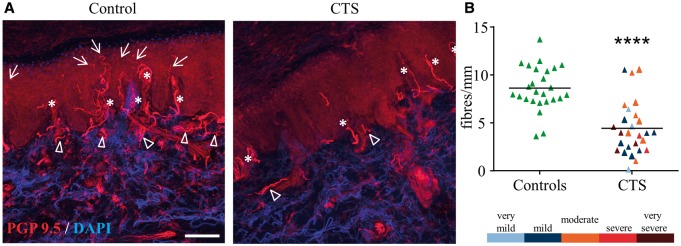
Patients with carpal tunnel syndrome have a reduced intraepidermal nerve fibre density. Images in (A) show representative skin biopsy sections from an age matched control participant (left) and a patient with carpal tunnel syndrome (CTS, right). Whereas there is an abundance of axons (red, protein gene product, PGP9.5) in the subepidermal plexus (arrow heads), the papillae (asterisks) and the epidermis (arrows) in the control skin, the skin of the patient with carpal tunnel syndrome shows a reduced density of axons in the subepidermal plexus and a clear reduction of axons piercing into the epidermis. Scale bar = 100 µm. The graph in B shows the mean intraepidermal nerve fibre density expressed as fibres per mm epidermis as well as single data points. Patients with carpal tunnel syndrome have a significantly lower intraepidermal nerve fibre density than the matched control group. This reduction was independent of electrodiagnostic test severity (colour coded according to the bar below). ****P < 0.0001.